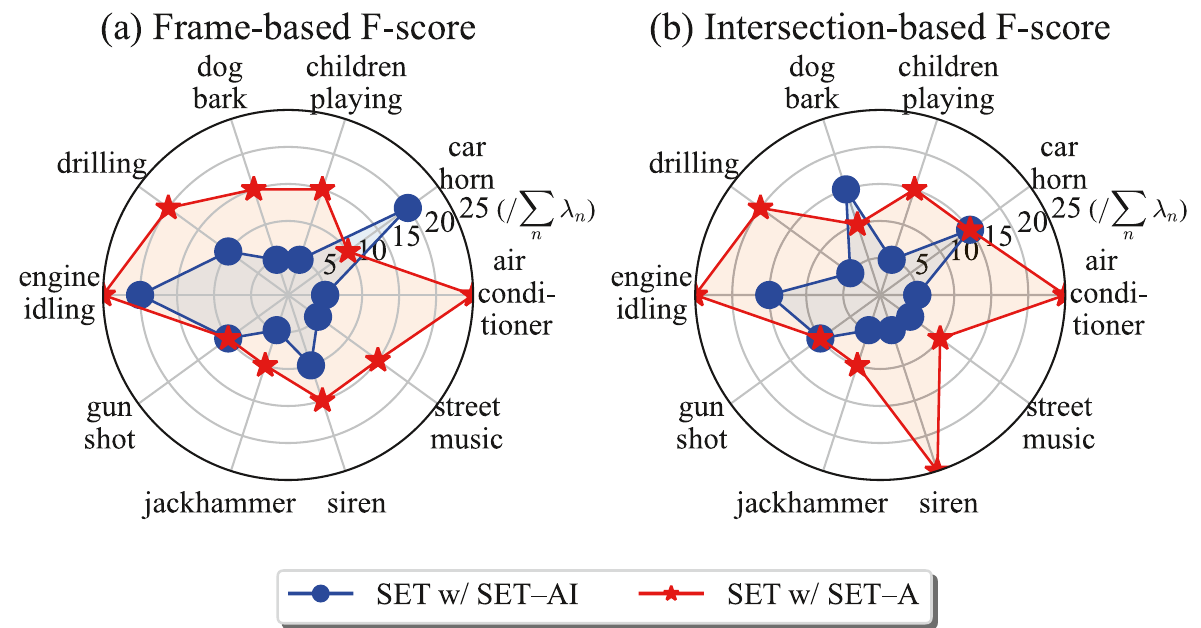
Fig. 10 Optimal triage weights for each event class and evaluation